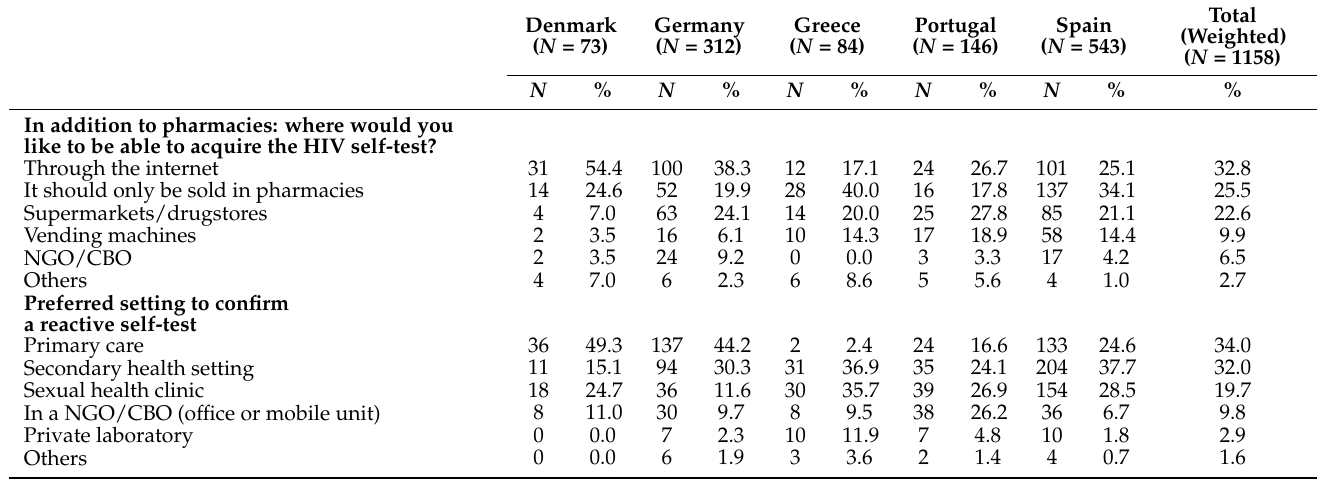
Table 3. Preferred setting to acquire an HIV self-testing kit and to confirm a reactive result in men who have sex with men who chose self-testing as their preferred testing